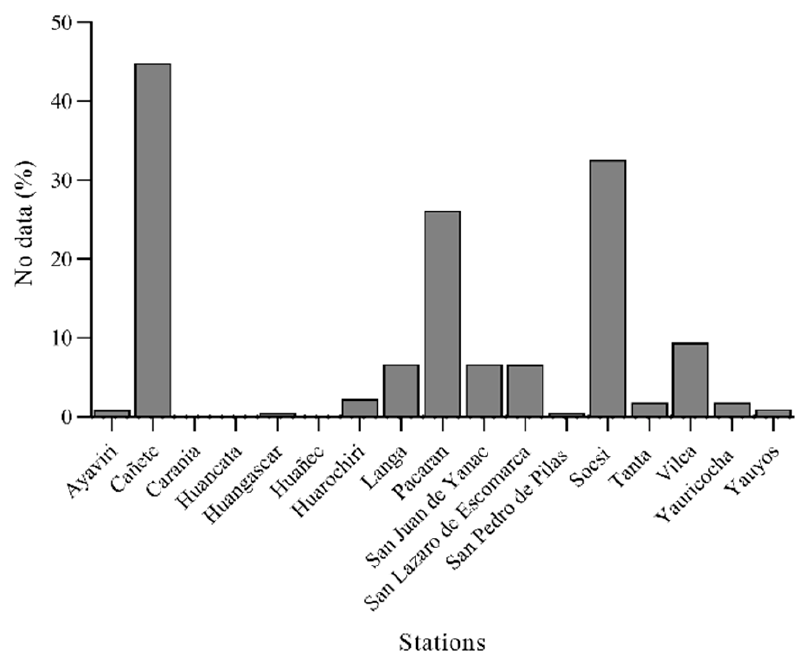
Figure 3. Missing daily precipitation data: quantity of unavailable daily precipitation data as a percentage by station.